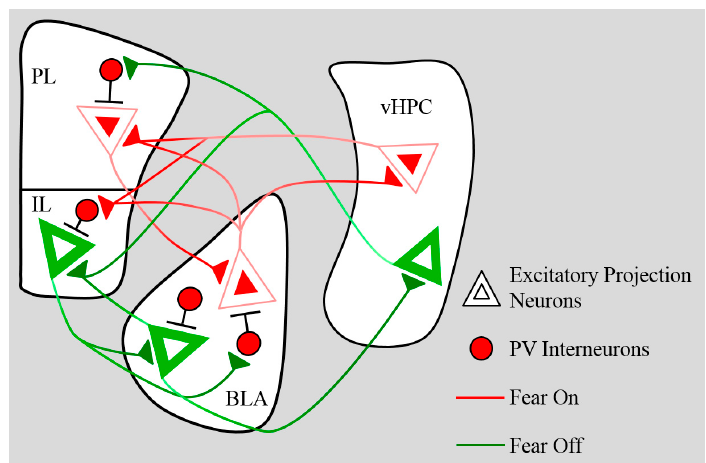
Figure 2. Pathways for Fear and Extinction. Projection neurons in the basolateral amygdala (BLA) and ventral hippocampal (vHPC) target both excitatory neurons and inhibitory interneurons in the medial prefrontal cortex (mPFC). The mPFC targets excitatory and inhibitory cells in the BLA, although innervation of BLA parvalbumin (PV) interneurons comes more strongly from the infralimbic (IL) than the prelimbic (PL). Red pathways represent proposed mechanisms for fear expression, whereas green pathways would promote extinction.